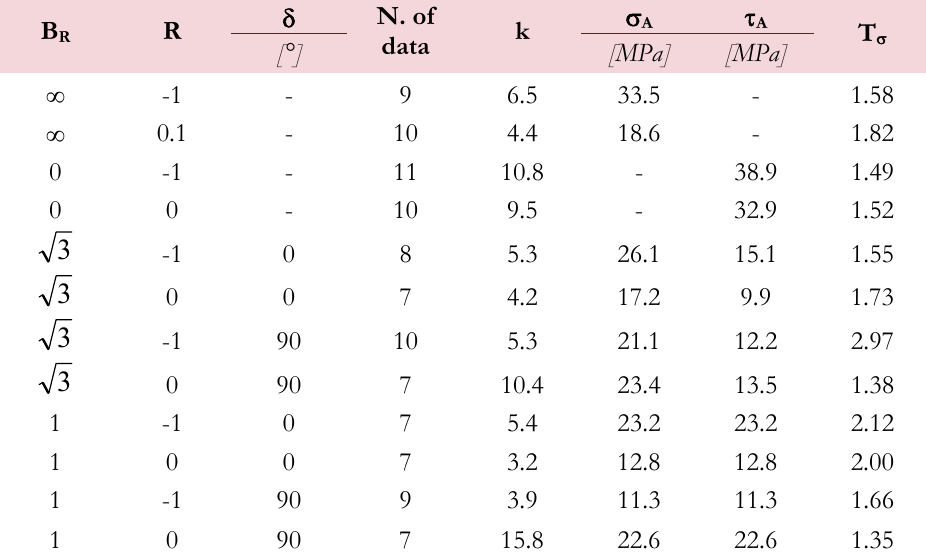
Table 1: Summary of the generated experimental